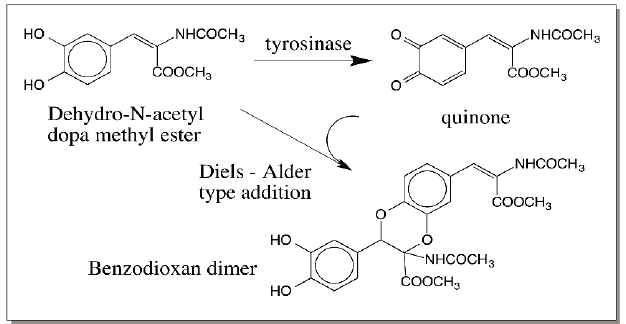
Figure 26. Oxidative dimerization of 1,2-dehydro- N -acetyldopa methyl ester. Oxidation of 1,2-Dehydro- N -acetyldopa methyl ester by tyrosinase results in the production of conventional quinone product and not the quinone methide analog. This quinone also dimerizes and produces the same benzodioxan type adduct as that produced by dehydro NADA but by an ionic Diels–Alder type reaction.